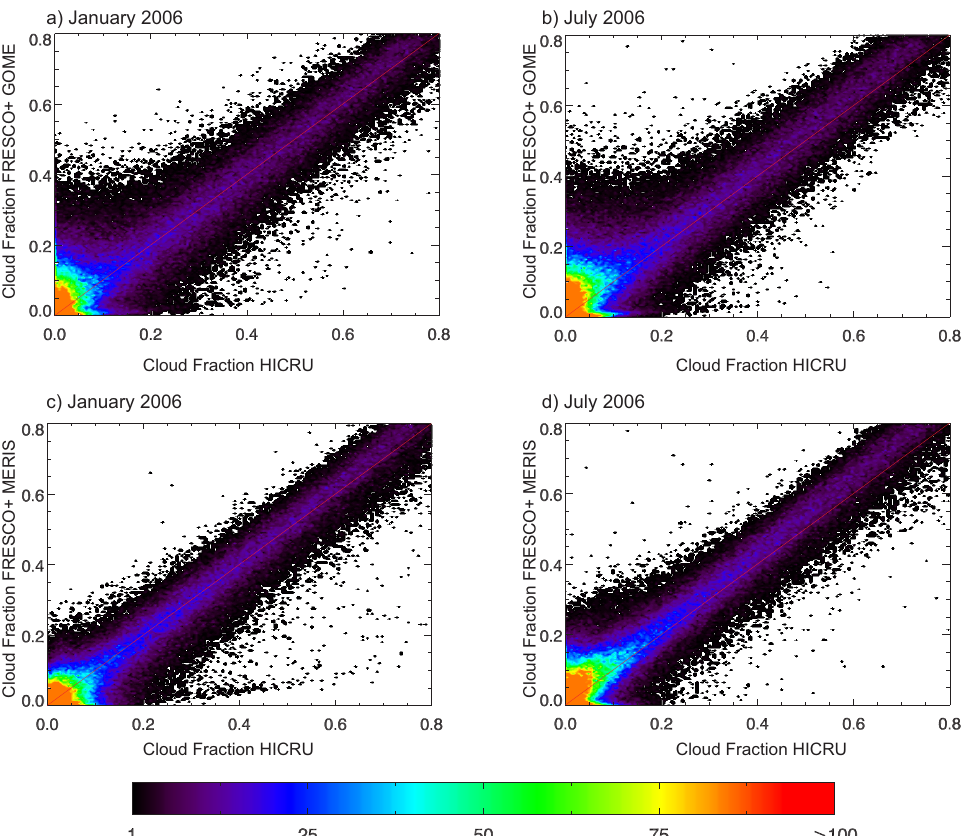
Fig. 9. FRESCO+ effective cloud fractions (upper panels with GOME LER, lower panels with MERIS BSA) as a function of HICRU cloud fractions for latitudes between 50 ◦ N and 50 ◦ S and snow/ice-free observations and for January (left) and July 2006 (right), respectively. FRESCO+ effective cloud fractions are converted to a cloud albedo of 0.9 and only cloud fractions < 0 . 8 are considered (see